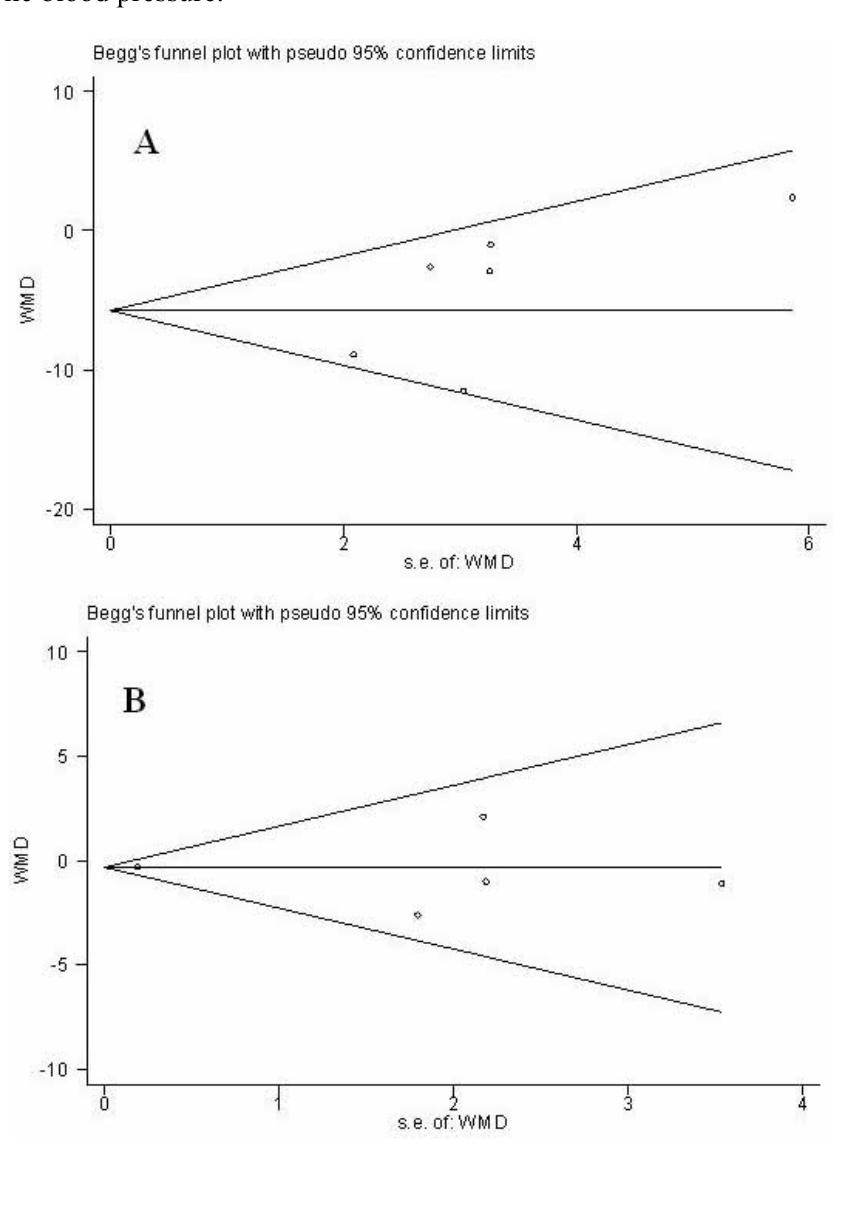
Figure 3. Funnel plot analysis to detect publication bias. ( A ): Systolic blood pressure; ( B ): Diastolic blood